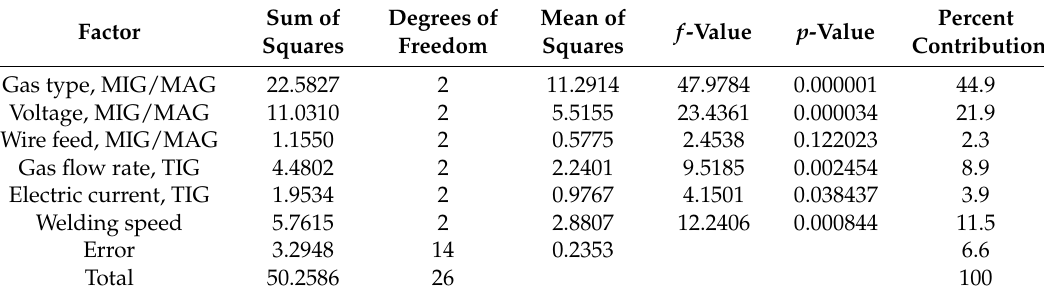
Table 5. Variance analysis for the width of the weld